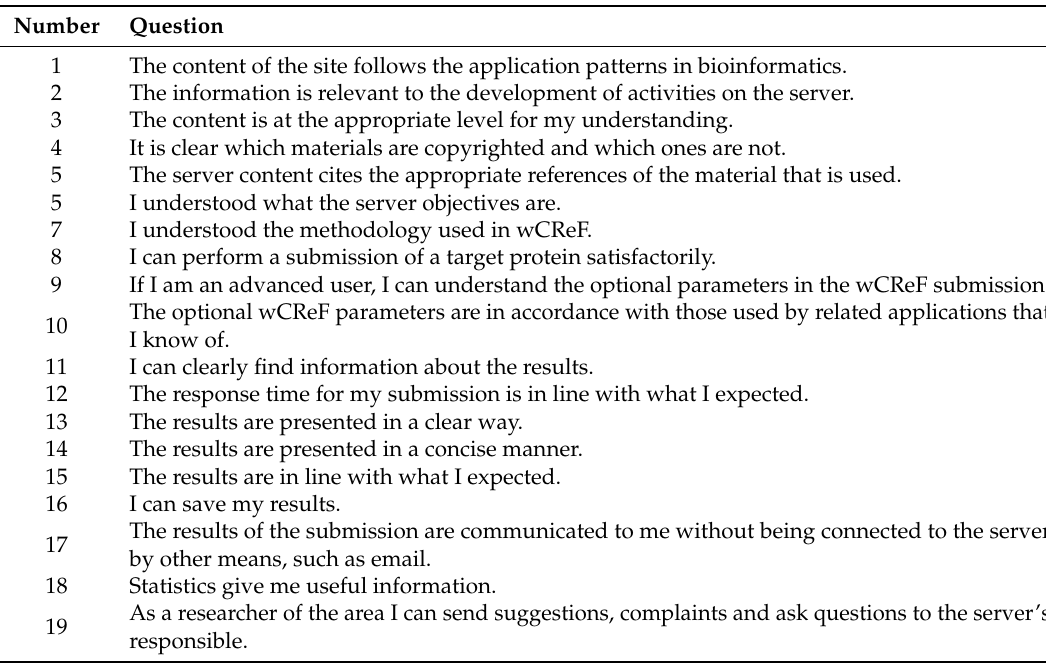
Table 7. Usability satisfaction questions for the bioinformatics area regarding protein structure prediction